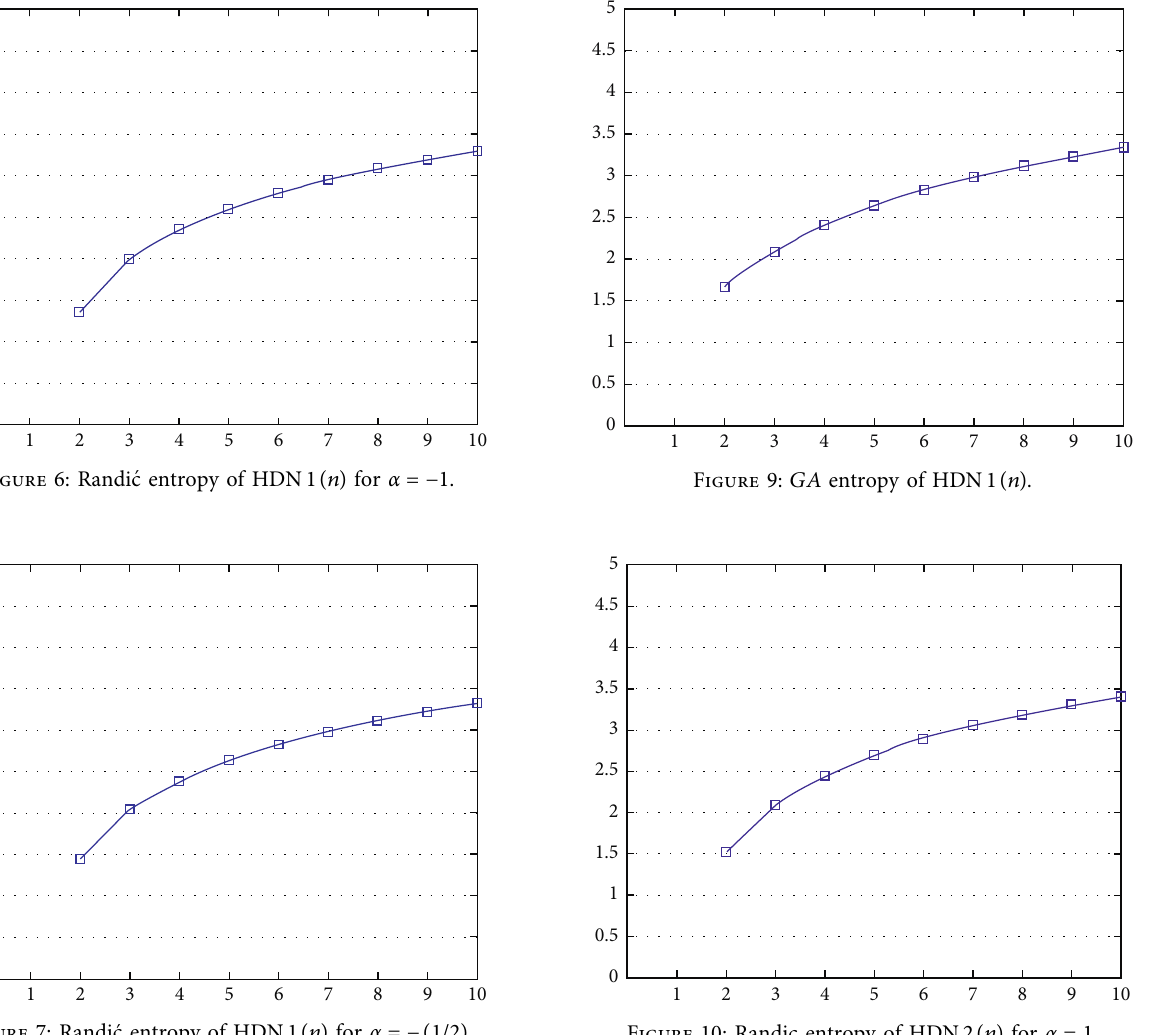
Figure 10: Randic entropy of HDN2 ( n ) for α � 1.